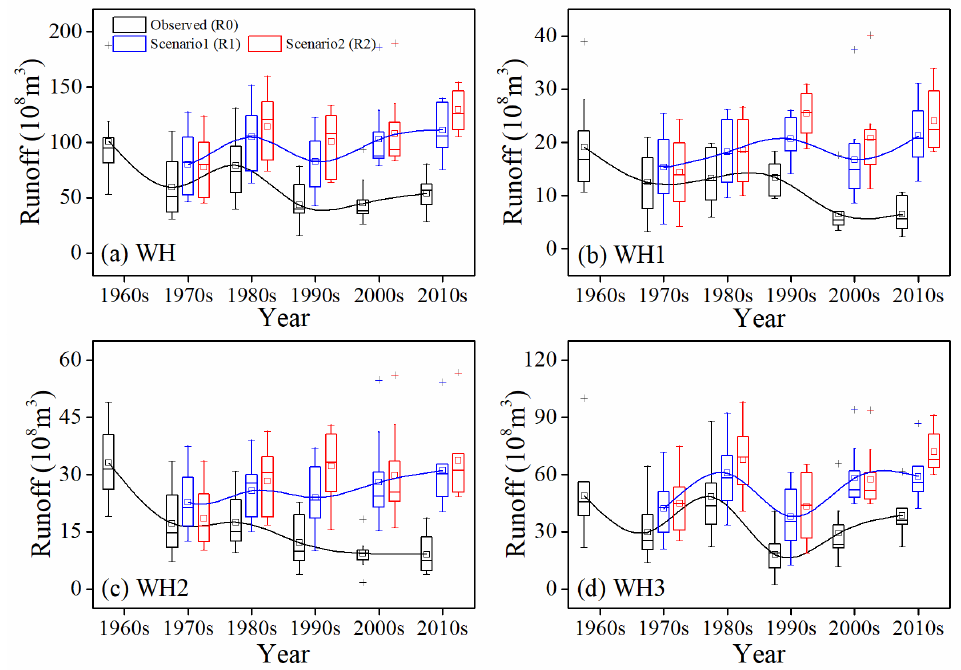
Figure 11. Annual runoff of ( a ) the Weihe River basin (WH) and the three sub-regions, i.e., ( b ) WH1, ( c ) WH2, and ( d ) WH3, in the three scenarios for each decade since the 1960s. Based on the observed runoff and simulated runoff in two scenarios, the relative contribution of climate change and human activity to runoff variation for each period were quantified (Figure 12).